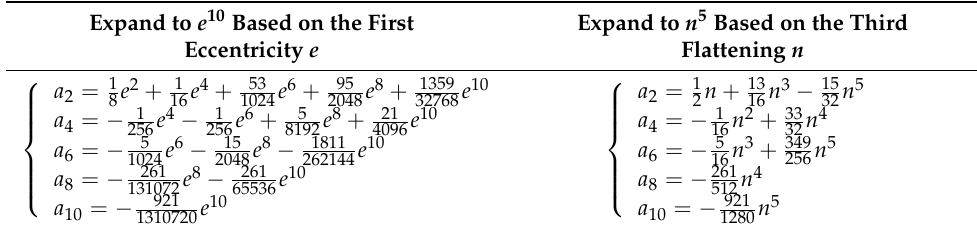
Table 7. Coefficients in Equation (24).